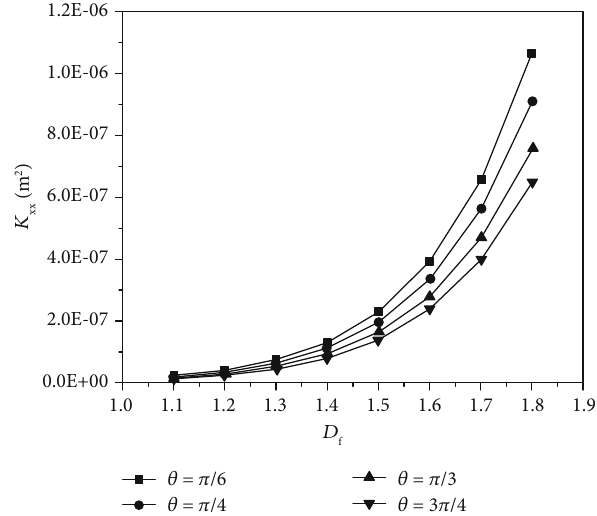
Figure 8: The relationship between K and α = π /4 ).